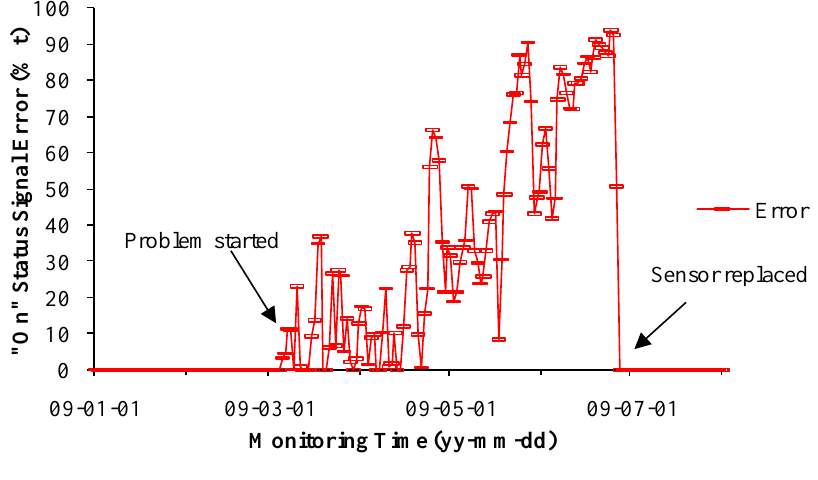
Figure 8. The absolute error between unsteady and normal sensor signals from January 1